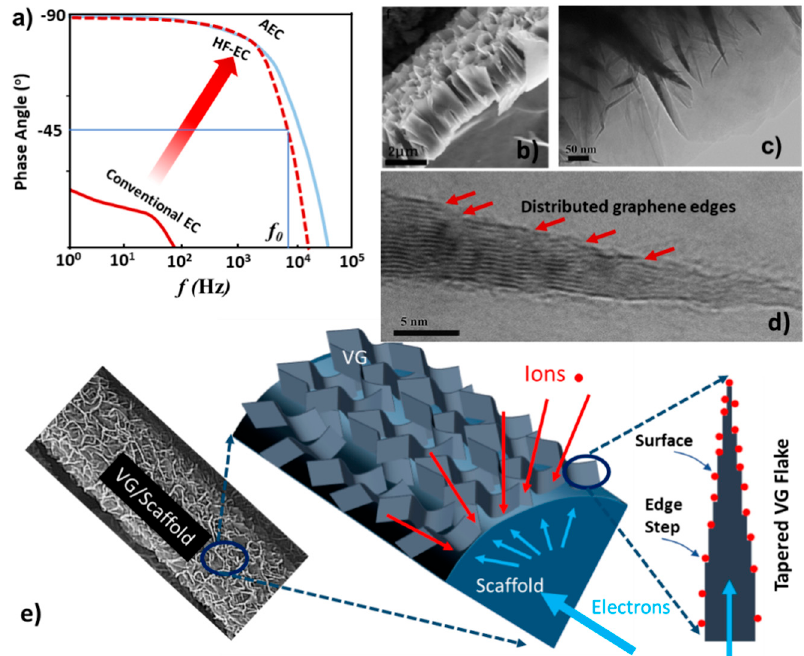
Figure 1. ( a ) Schematic showing the phase angle difference between conventional EC and AEC to appreciate their different frequency responses. HF-EC has a frequency response close to that of AEC, but with a much larger capacitance density. ( b ) SEM cross-sectional view of VG structure. ( c ) TEM image of vertical graphene sheets. ( d ) High-resolution TEM image of an individual sheet showing its tapered geometry with fully exposed graphene edges. ( e ) Schematic showing the VG network grown on a scaffold that offers high electronic conductivity and relatively large surface area provided by exposed graphene edges. Reproduced with permission from Ref. [1] for ( a ), Copyright 2017, Ref. [5] for ( b ), Copyright 2014, Ref. [6] for ( c , d ), Copyright 2016, and Ref. [9] for ( e ), Copyright 2019, Elsevier.